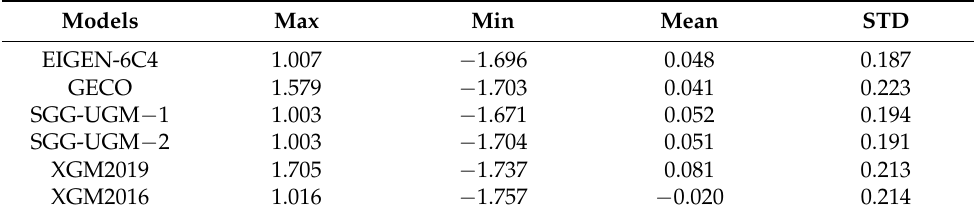
Table 4. Statistics of the height anomaly differences between GNSS/leveling and six higher-degree GFMs. Unit: m.